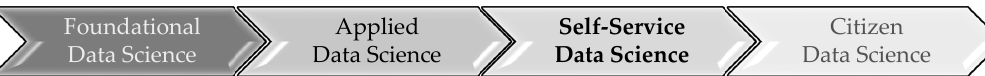
Figure 1. Self-service data science research in context of related data science disciplines.